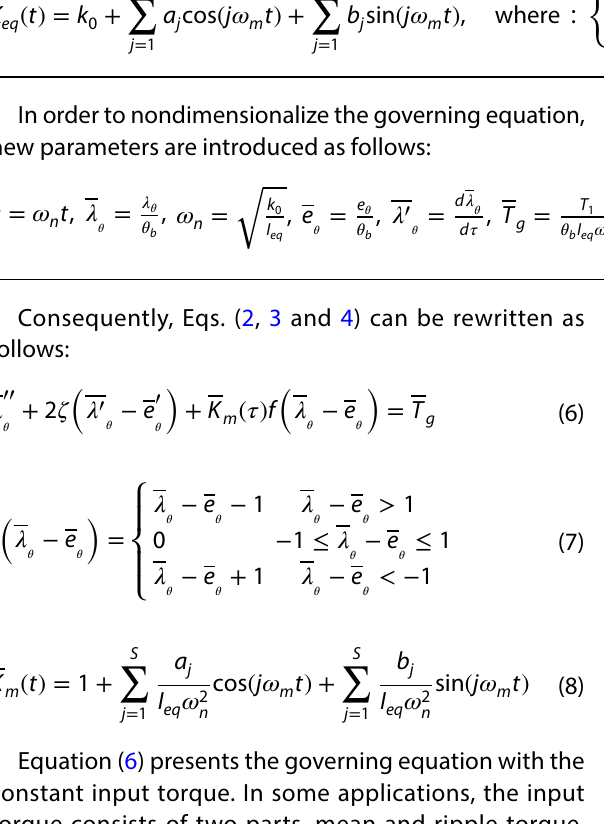
Table 1 geometric parameters of the SBG pairs